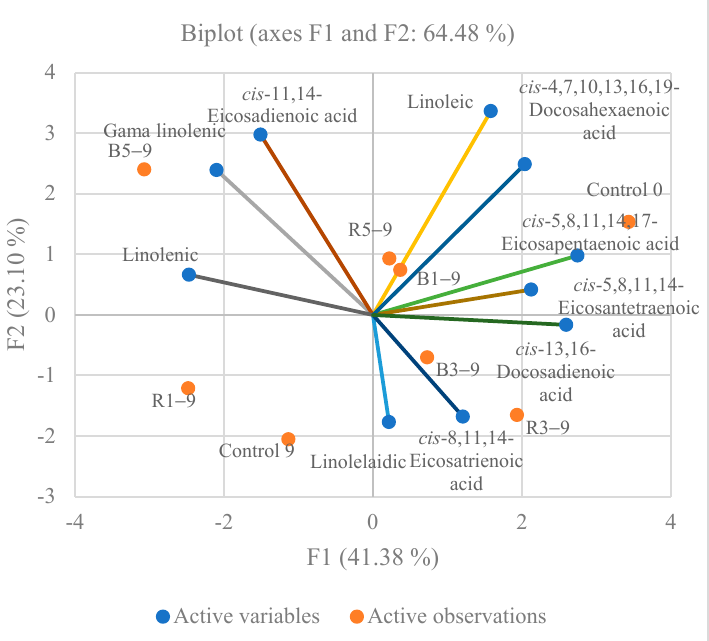
Figure 5. Principal component analysis (PCA) for polyunsaturated fatty acids of meat patties with different berries pomace additives stored for nine days (Control 0—meat patties without additives before storage; Control 9—without additives stored for 9 days); R1–9 and B1–9—with 1% of raspberry and blackberry pomace additives after 9 days of storage; R3–9 and B3–9—with 3% of raspberry and blackberry pomace additives after 9 days of storage; R5–9 and B5–9—with 5% of raspberry and blackberry pomace additives after 9 days of storage).